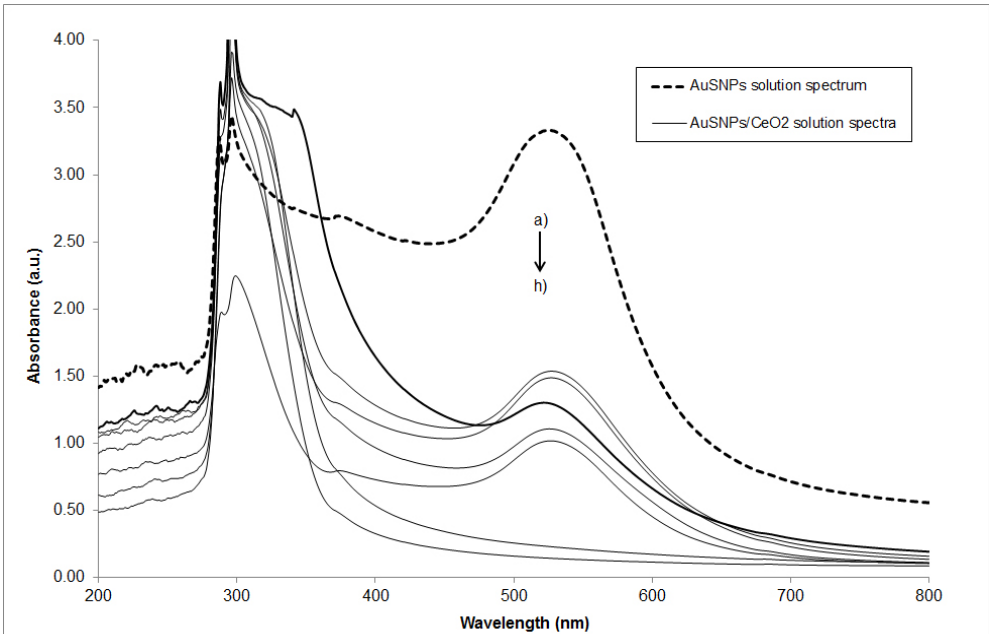
Figure 3. UV-visible spectra recorded for AuSNPs/CeO different stirring times: ( a ) AuSNPs spectrum immediately after the synthesis; AuSNPs/CeO nanoparticles spectra after stirring ( b ) 15 min; ( c ) 30 min; ( d ) 45 min; ( e ) 1 h; 2 ( f ) 2 h; ( g ) 8 h and ( h ) 10